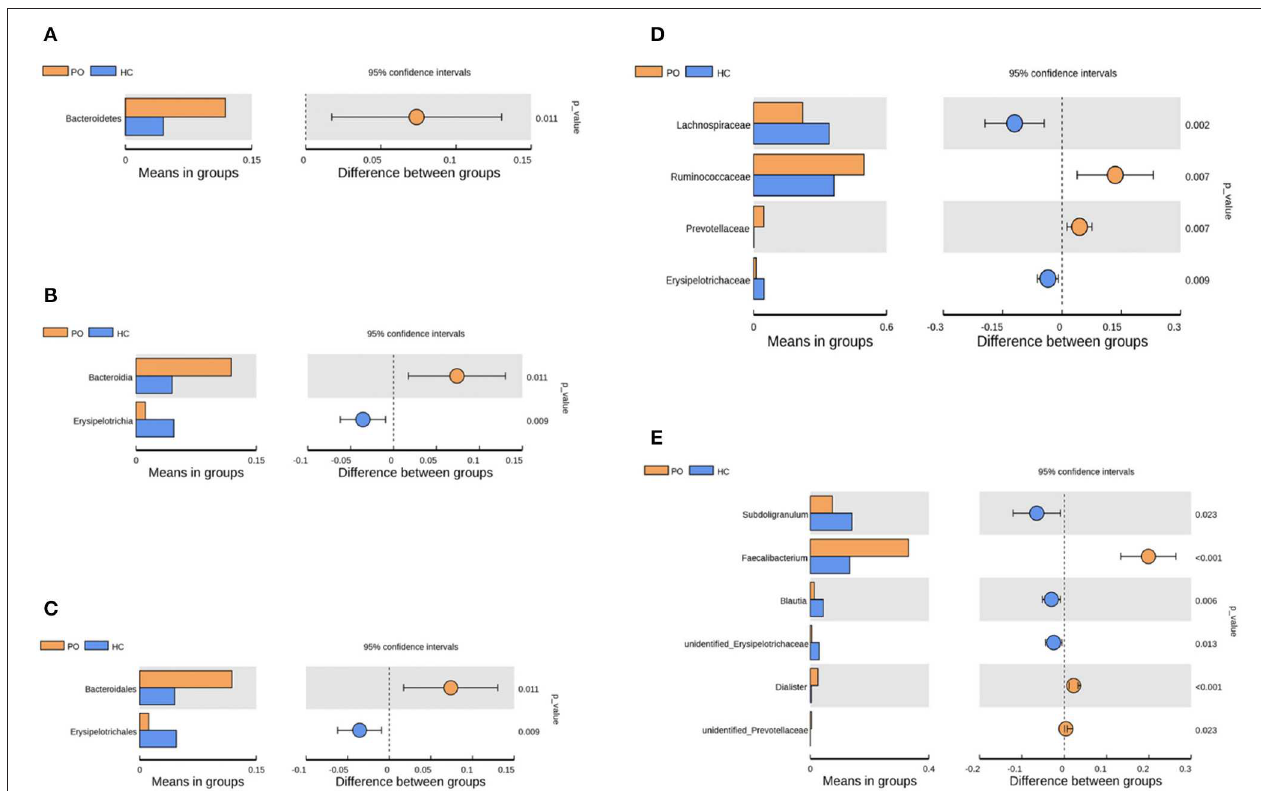
FIGURE 3 | Species analysis of differences between groups by T -test between groups. Differential species between the two groups at the phylum (A) , class (B) , order (C) , family (D) , and Genus (E) classification levels. In each of the figures, the left panel shows the abundance of species differences between groups, and each bar in the graph represents the mean of each species in each group with significant differences in abundance between the groups. The graph on the right shows the difference between the confidence levels of the groups. The leftmost endpoint of each circle in the figure represents the 95% confidence interval lower limit of the mean difference, and the rightmost endpoint of the circle represents the 95% confidence interval upper limit of the mean difference. The center of the circle represents the difference in the mean. The group represented by the circle color is a group with a high mean. At the far right of the displayed results is the inter-group significance test p -value for the corresponding species (Orange, PO; Blue,